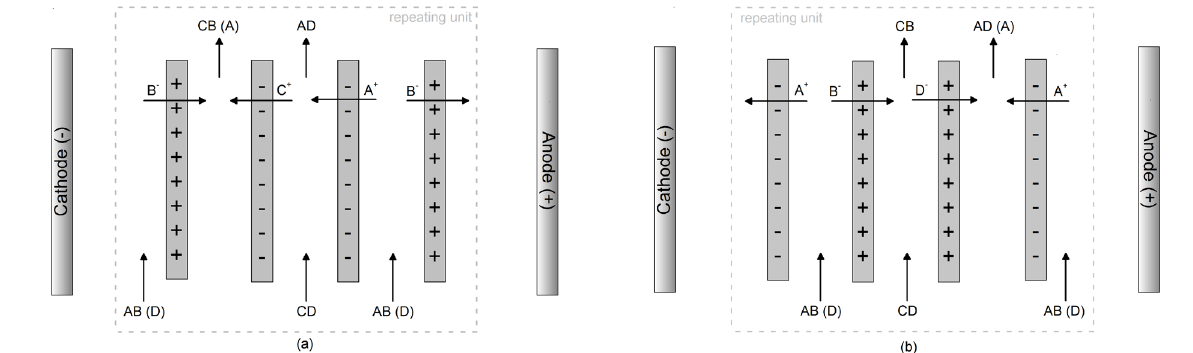
Figure 5: Schematic representation of two possible configurations of ion substitution electrodialysis. A-acceptor solution, D – donor